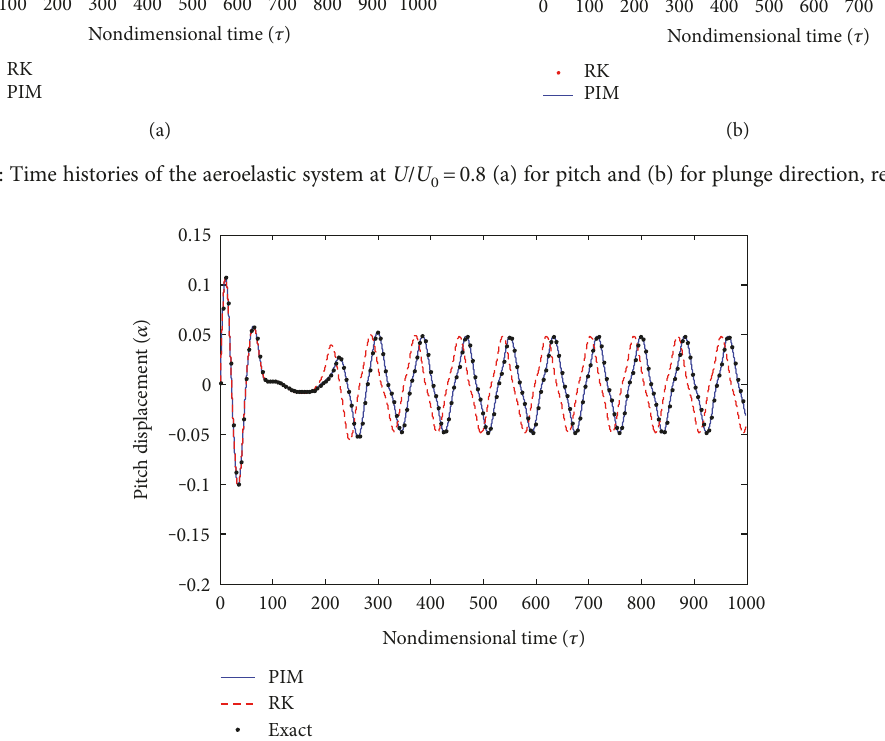
Figure 10: Time histories of the aeroelastic system at U / U